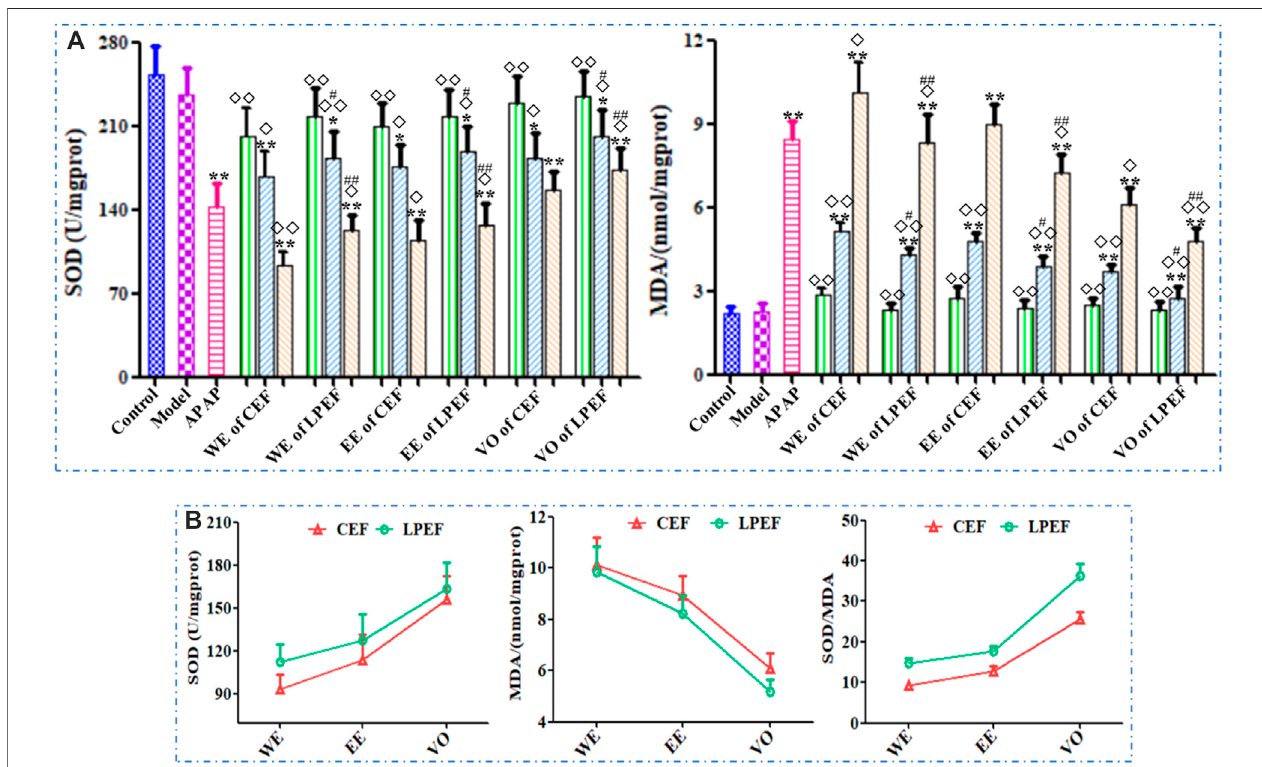
FIGURE 5 | Effects of 21 groups of samples on serum SOD and MDA activities (A) , and comparison of SOD, MDA activities, and SOD/MDA between different extractsathighdose (B) .Valuesareexpressedasmean ± SD, n (cid:2) 10;vs.controlgroup, p < 0.05( * )and p < 0.01( ** );vs.CEF, p < 0.05( # )and p < 0.01( ## );vs.APAP, p